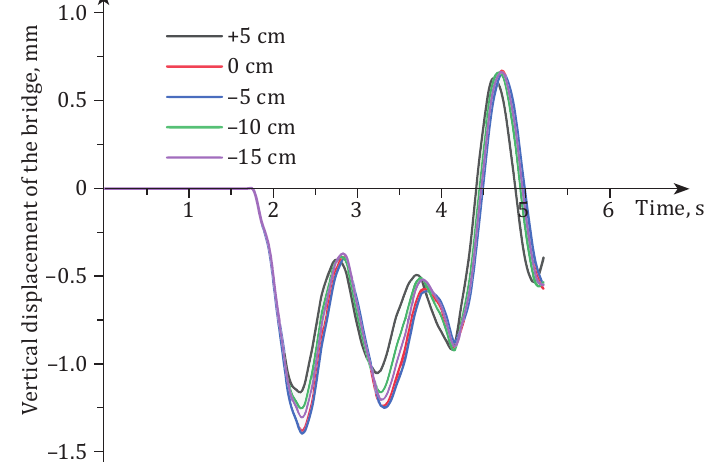
Figure 17. Comparison of vertical displacement time